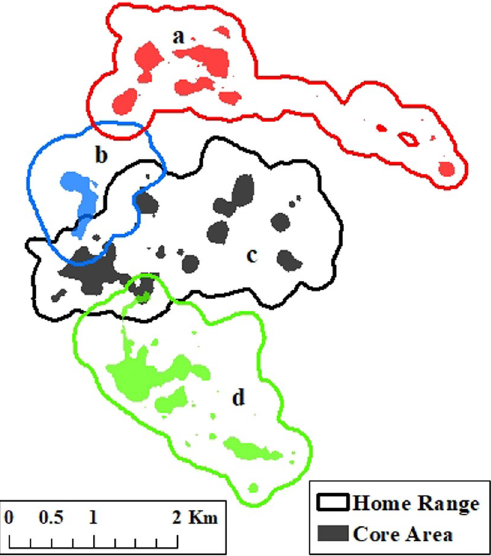
Figure 2. Home range (HR) and core area (CA) overlap of 4 female wild pigs at Buck Island Ranch, FL, during the Dry 2017 season. As an example, overlap of home ranges (HR–HR) occurs between 3 pairs of individuals (a–b, b–c, and c–d), overlap of home ranges and core areas (HR–CA) occurred between two pairs (b–c and c–d), and core area overlap (CA–CA) occurred between one pair (c–d). Figure was created in ArcMap 10.1.